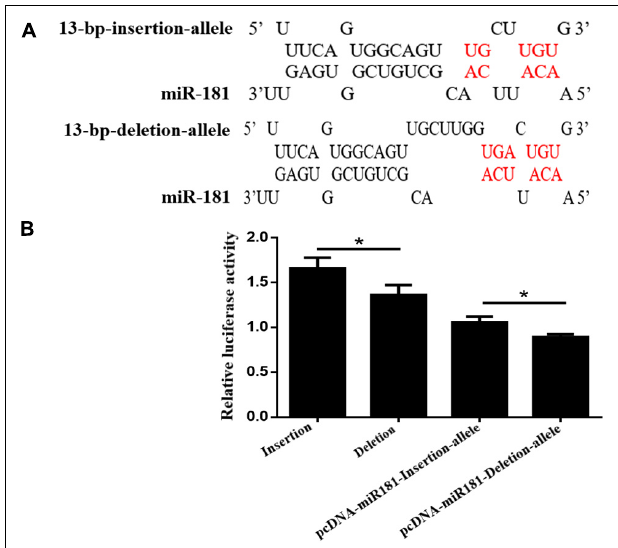
FIGURE 3 | (A) The 13-bp indel locus influences the binding of miR-181 and goat AKAP12 3 (cid:48) UTR. (B) HEK293T cells transfected with the psiCHECK-2 plasmids (DD or II types) or co-transfected with pcDNA-miR-181. The relative luciferase activity was plotted on the Y axis and data were presented as means ± SE. * P <